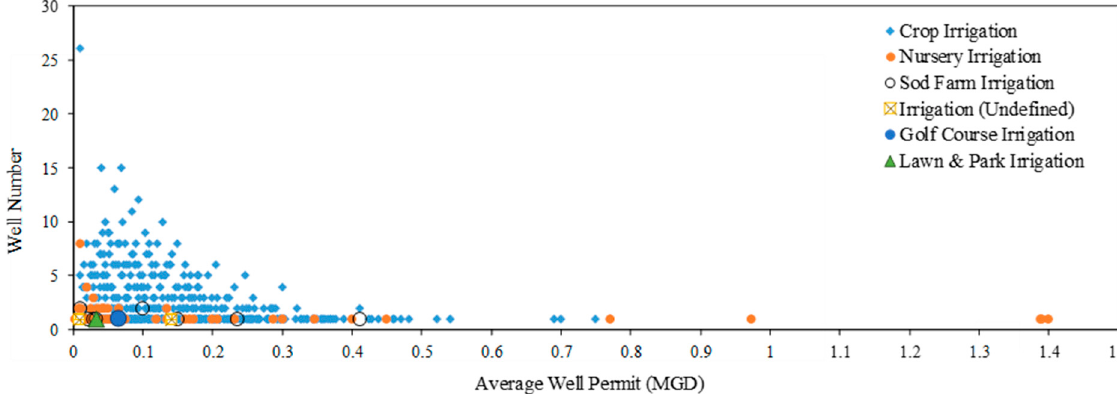
Figure A3. Number of wells that are categorized based on the permitted average withdrawal. Figure A2. Number of wells that are categorized based on the permitted average